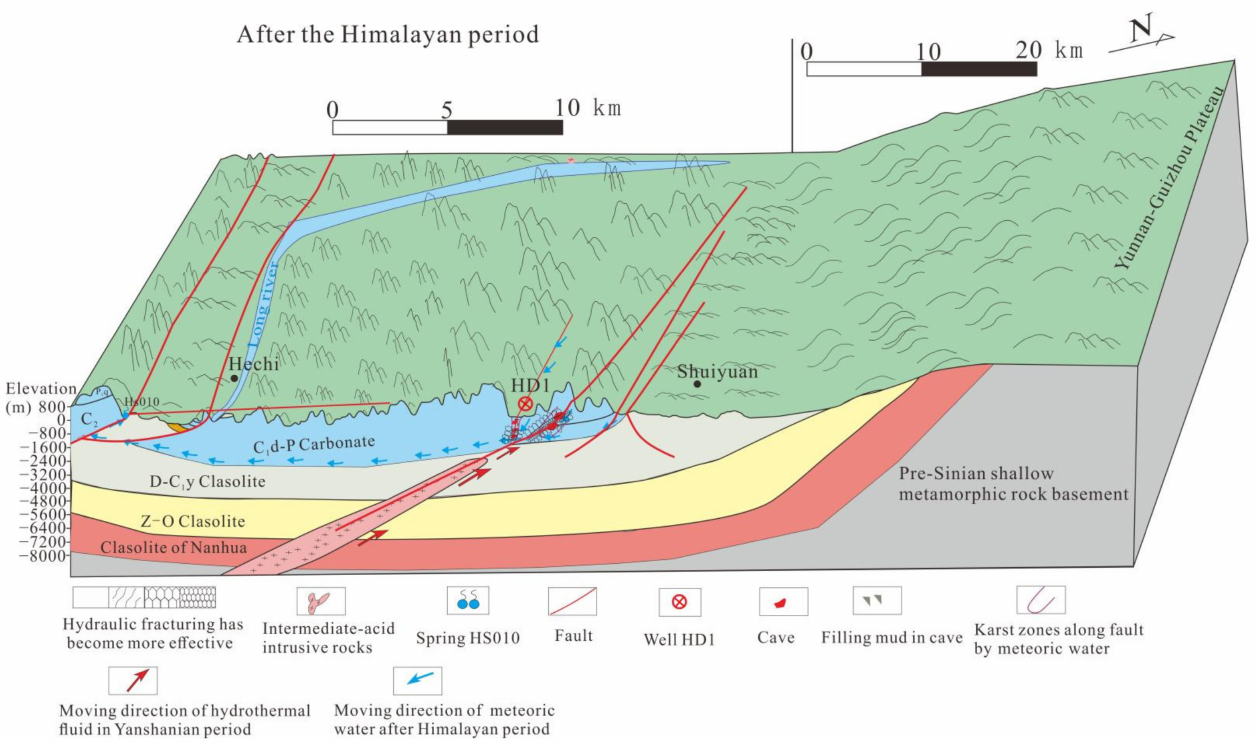
Figure 12. Meteoric water deep circulation karst after the Himalayan period in Huanjiang Sag. The Yunnan-Guizhou Plateau was uplifted after the Himalayan period, and the strata denudation caused the fault to open to earth. A deep karst space developed again along the fault through meteoric fresh water. The dissolution characteristics of the fault zone are shown in Figure